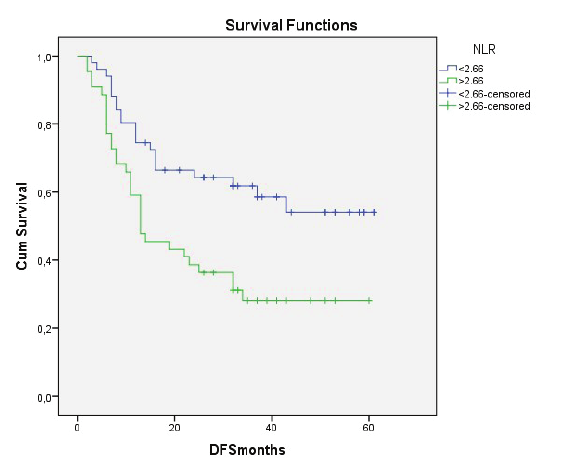
Figure 1a - Kaplan-Meier Curve for Overall survival of low and high neutrophil-lymphocyte ratio